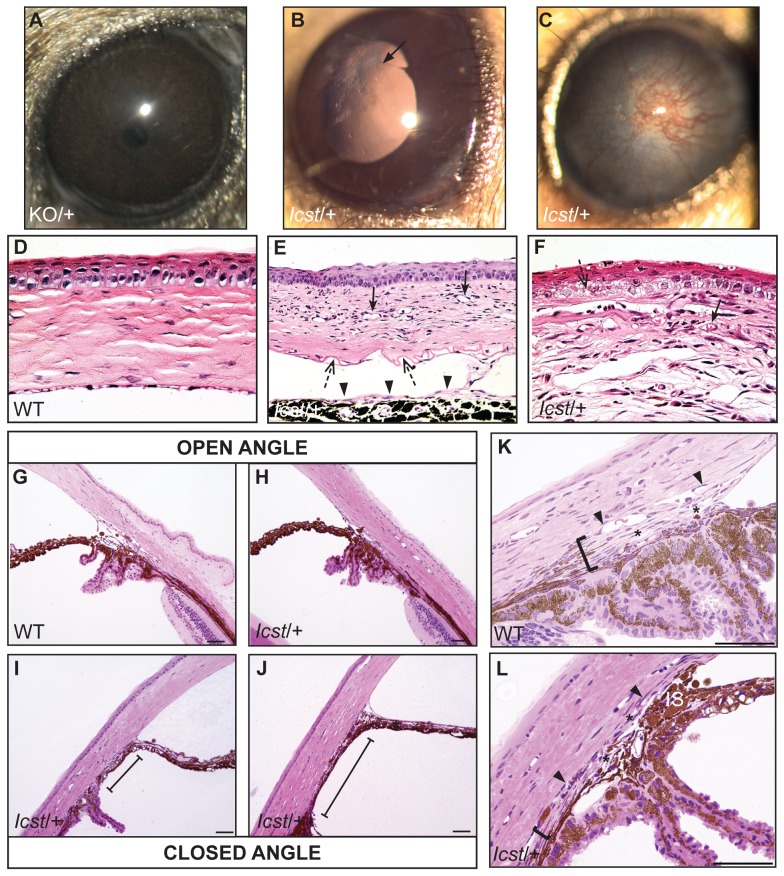

Icst causes defects in the anterior segment of the eye.(A) Lmx1bKO/+ (KO/+) eye that is of normal appearance. (B) Lmx1bIcst/+ (Icst/+) eye where there is a fine strand between the pupillary margin and the cornea (arrowed). (C) This Lmx1bIcst/+ eye is enlarged with severe corneal vascularisation and central opacity. (D–F). Histological appearance of corneas. (D) Wild-type normal cornea (WT). (E) Lmx1bIcst/+ cornea that has stromal vascularisation (barbed arrows). Descemet's membrane is wrinkled (dashed arrows) and a membrane is present on the anterior surface of the iris (arrowheads). (F) Lmx1bIcst/+ cornea with basal epithelial oedema (dashed arrow). A stromal blood vessel with red blood cells is indicated by a barbed arrow. (G) Normal wild-type iridocorneal angle. (H–J) Iridocorneal angle morphology of Lmx1bIcst heterozygotes display a spectrum of phenotypes ranging from open-angle (H) to closed-angle morphology where the iris can be seen adhering to the cornea and blocking the iridocorneal angle as indicated by bars (I, J). (K–L) Higher magnification of wild-type (K) and Lmx1bIcst/+ (L) iridocorneal angles. (K) The wild-type has an open-angle with robust drainage structures ([). Schlemm's canal (arrowheads) is clearly identifiable and the trabecular meshwork (asterisks) has well-formed trabecular beams. (L) The Lmx1bIcst/+ iridocorneal angle is open but narrow. Iridocorneal strands (IS) are present. These are a normal feature of the mouse angle but are not present at all locations and do not prevent aqueous humor drainage. The drainage structures are not as robust as in the WT ([). Schlemm's canal is present but compressed (arrowheads) and the trabecular meshwork is hypoplastic (asterisks). Original magnification ×40 (D and F) and ×20 (E). Scale bar = 50 µm.